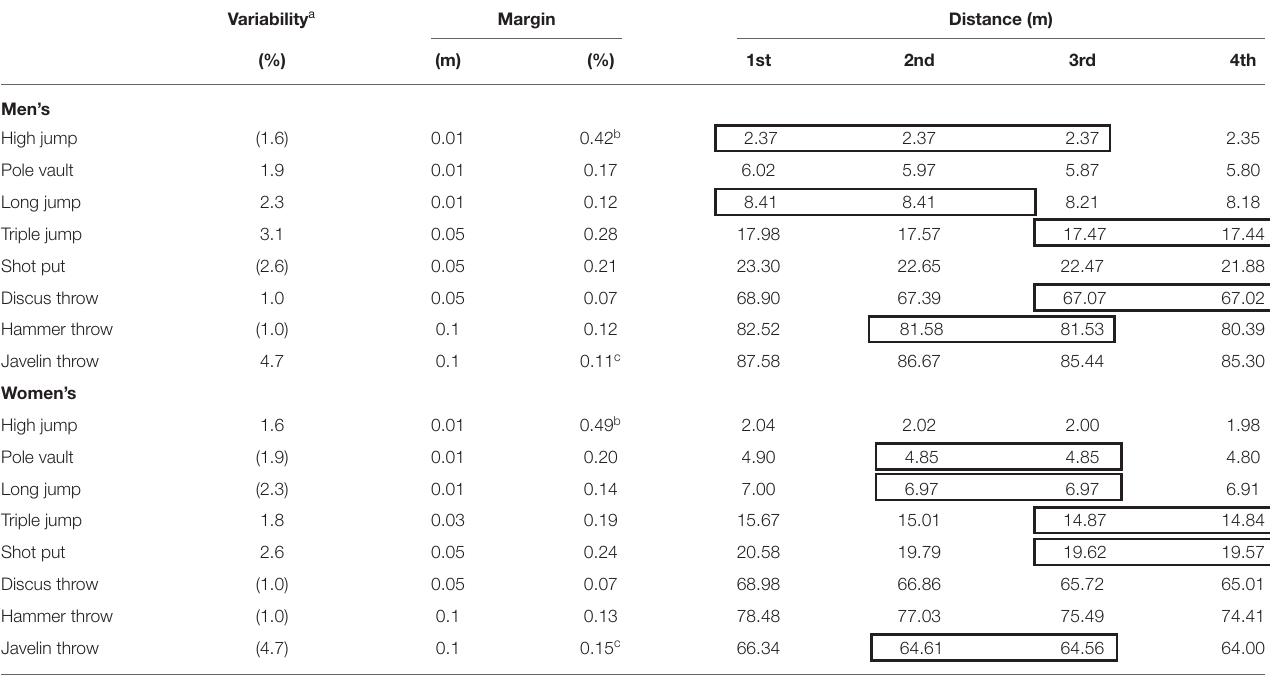
TABLE 1 | Variability of performance in field events, suggested margins for medal sharing derived from the variability, and performance distances of the first four place-getters at the Tokyo Olympics. Variability